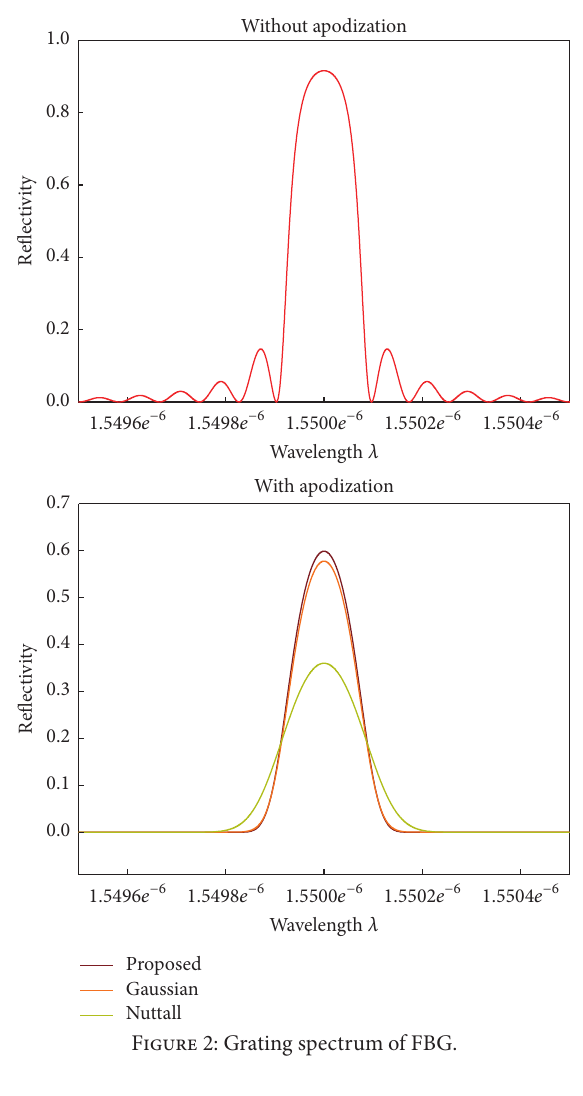
Figure 2: Grating spectrum of